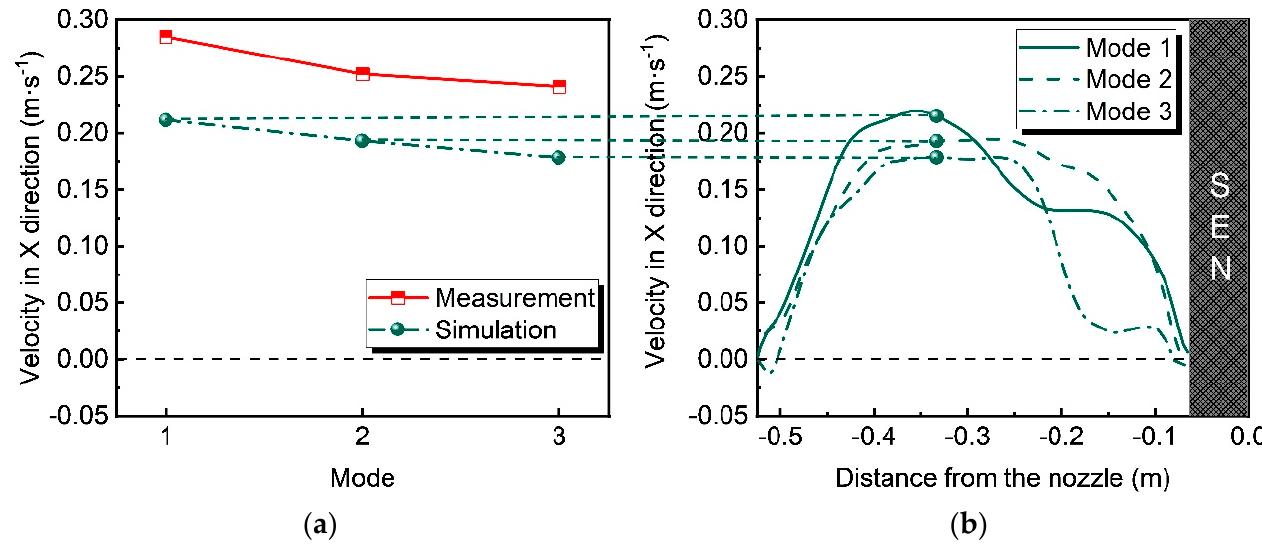
Figure 6. Comparison of the calculated and measured velocities of molten steel on the mold surface under the different EMBr modes. ( a ) Comparison between the calculated results and measured velocities; ( b ) calculated results.